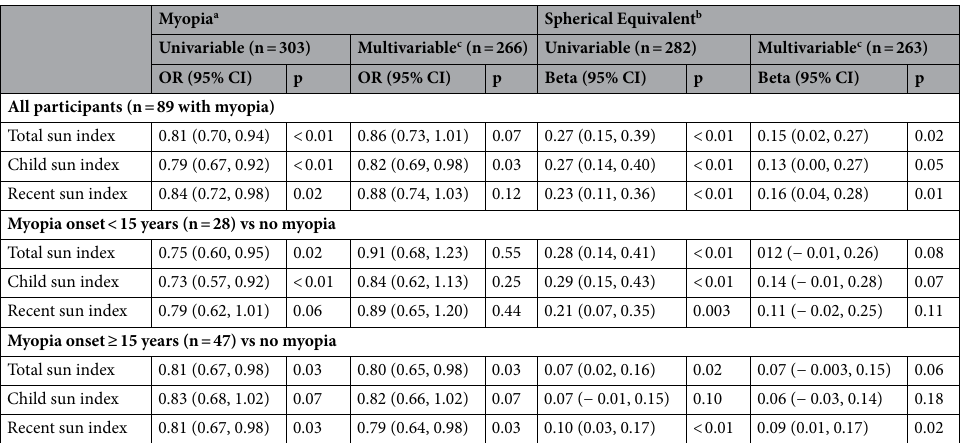
Table 4. Association between myopia or spherical equivalent and indices of time spent outdoors in the sun. One person missing recent sun exposure; three people with moderate- to high-hyperopia were excluded from analyses of spherical equivalent. All effect sizes per a 0.1 unit increase in factor score. a Logistic regression. b Linear regression. c Adjusted for age, sex, university education, outdoor occupation, parental myopia, parental education, Caucasian/non-Caucasian race and Kidskin Study intervention